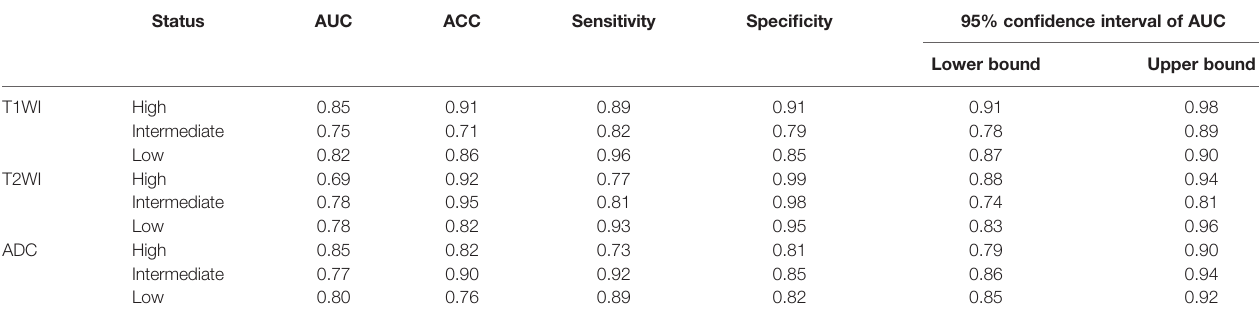
TABLE 3 | ROC of three single sequences for distinguishing different risk of GISTs.